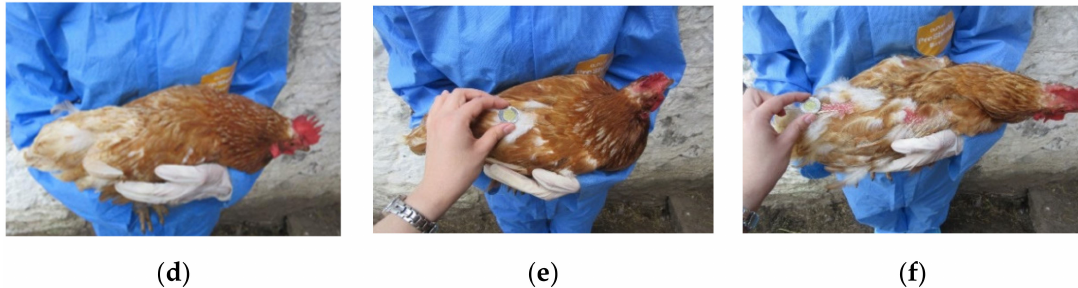
Figure 1. Visual representation of the developed scoring system for both white- and brown-feathered birds: score of 0 ( a , d ); score of 1 ( b , e ); score of 2 ( c , f